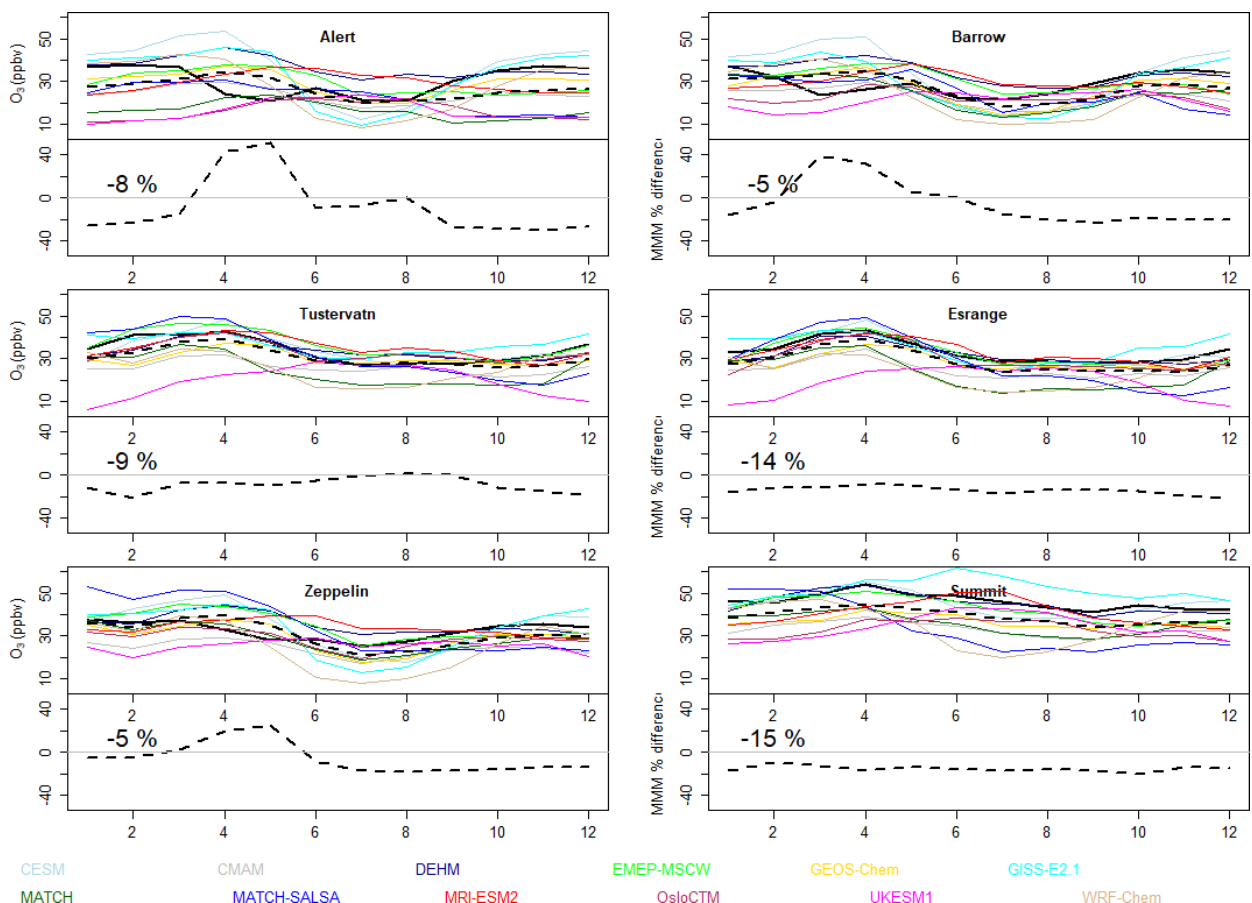
Figure 6. Arctic surface O 3 by month; seasonal cycle model comparisons. Top row: coastal high Arctic sites; middle row: sites near the Arctic Circle; bottom row: high-elevation sites. The solid black line is the observed O 3 monthly means, and the dashed black line is the multi-model median. Bottom row: sub-panels show the MMM percent difference [(MMM − measurements)/measurements × 100]. Note that model results are from the 2014–2015 mean. When available, the same years are used for the observations. However, Alert did not have data for 2014–2015, so its most recent years were used: 2010–2013. Summit had 2014 but only 1 month in 2015, so its 2013–2015 data were